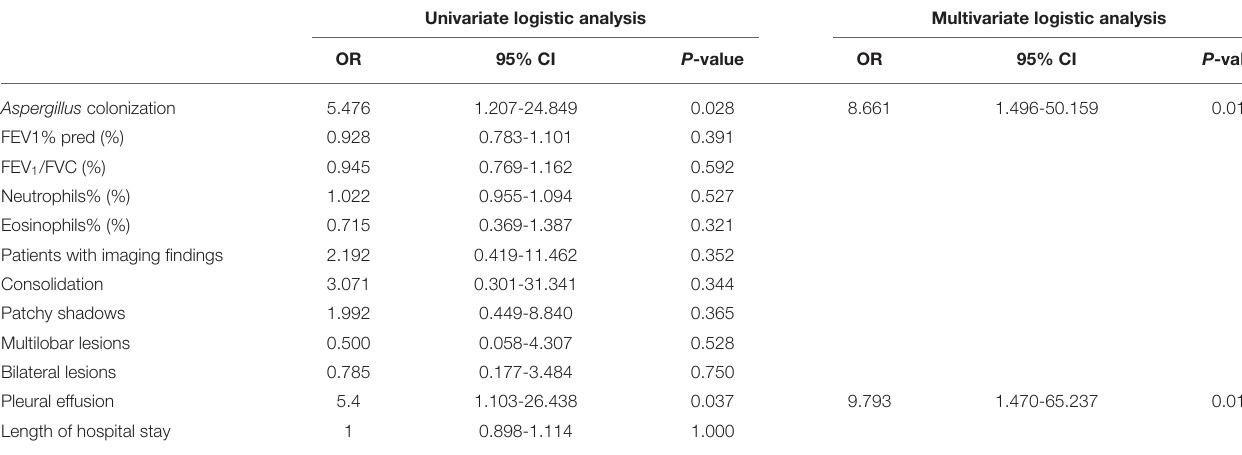
TABLE 5 | Univariate and multivariate logistic analysis for relapse of acute exacerbation in COPD patients within 90 days after discharge. Univariate logistic analysis Multivariate logistic analysis